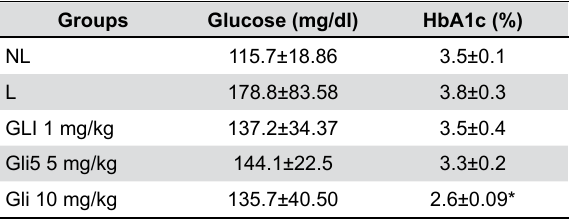
Table 1- Determination of the glucose and HbA1c. Biochemistry of periodontal disease experimental